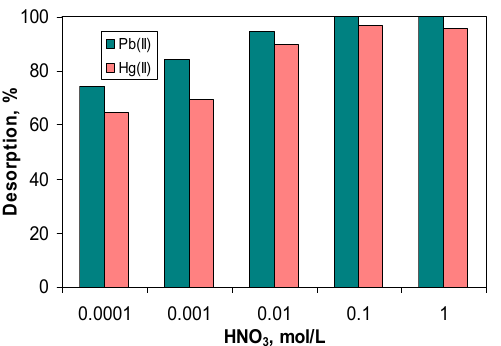
Figure 4. Desorption efficiency of Pb(II) and Hg(II) ions retained on RWB biosorbent.